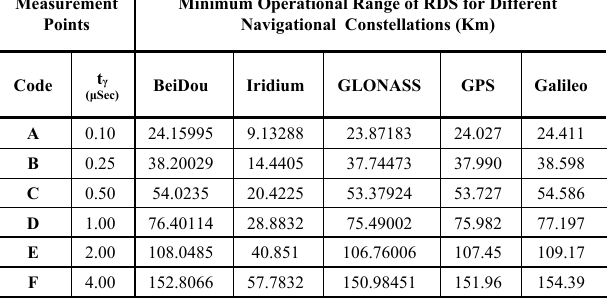
Figure. 3. Illustrated the R min for seven major